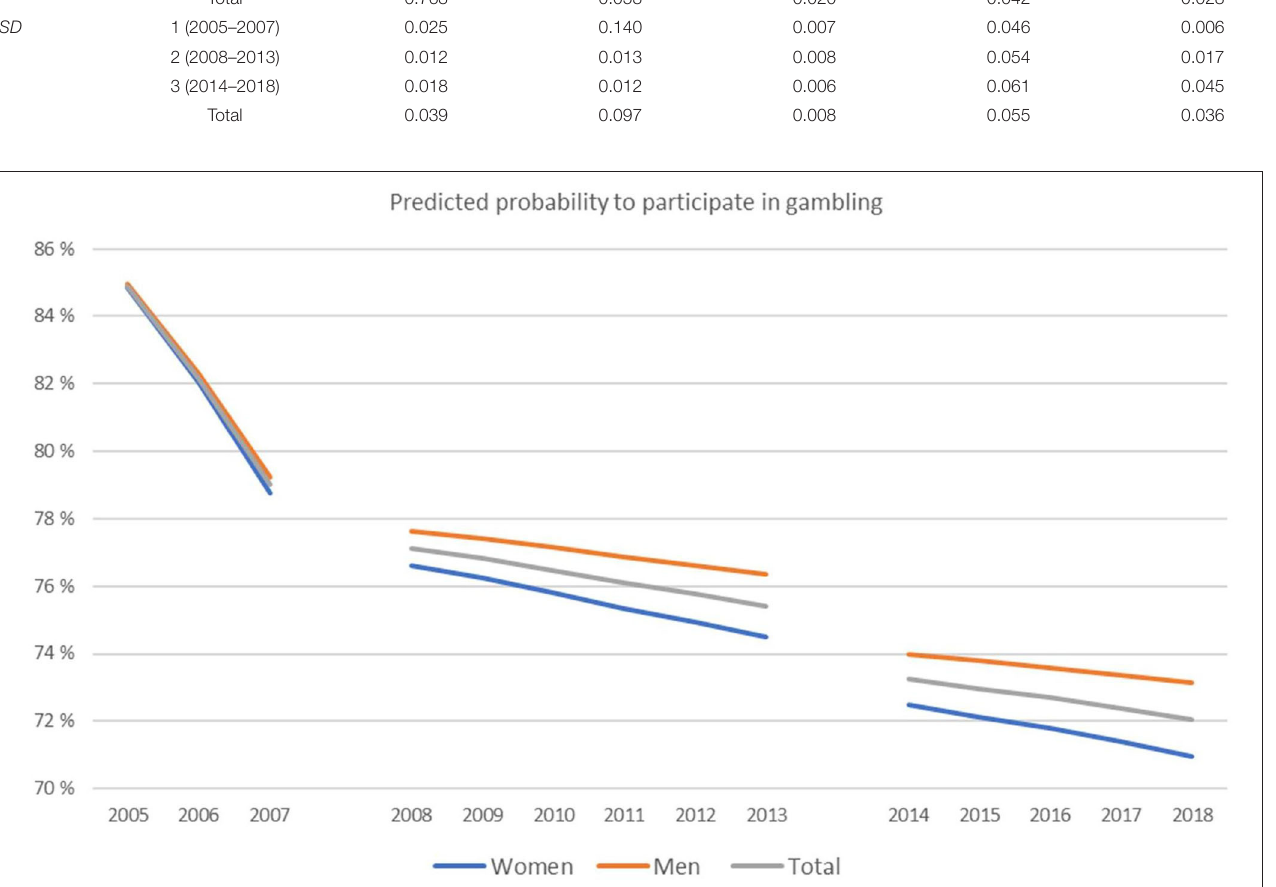
FIGURE 1 | Predicted probability to participate in gambling, one or more games, overall and by gender ( N = 28,251).